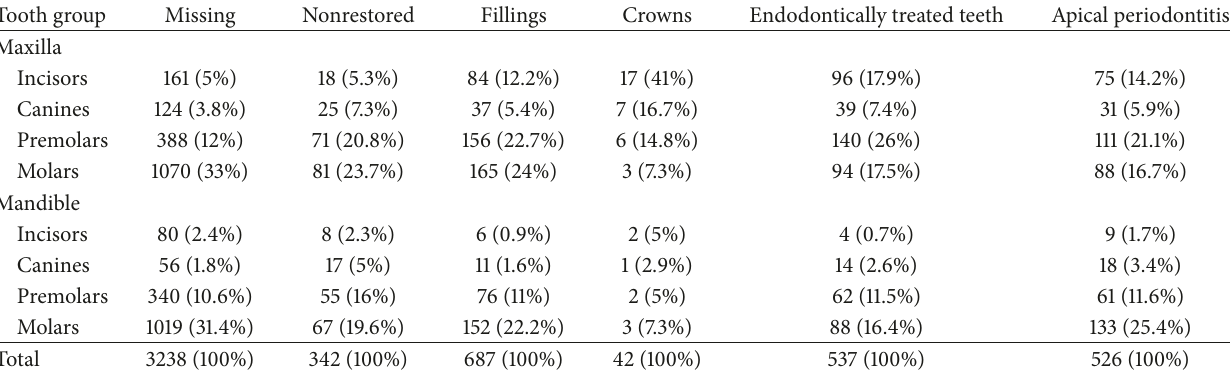
Table 1: Distribution of missing teeth, nonrestored teeth, fillings, crowns, endodontically treated teeth, and teeth with apical periodontitis according to tooth